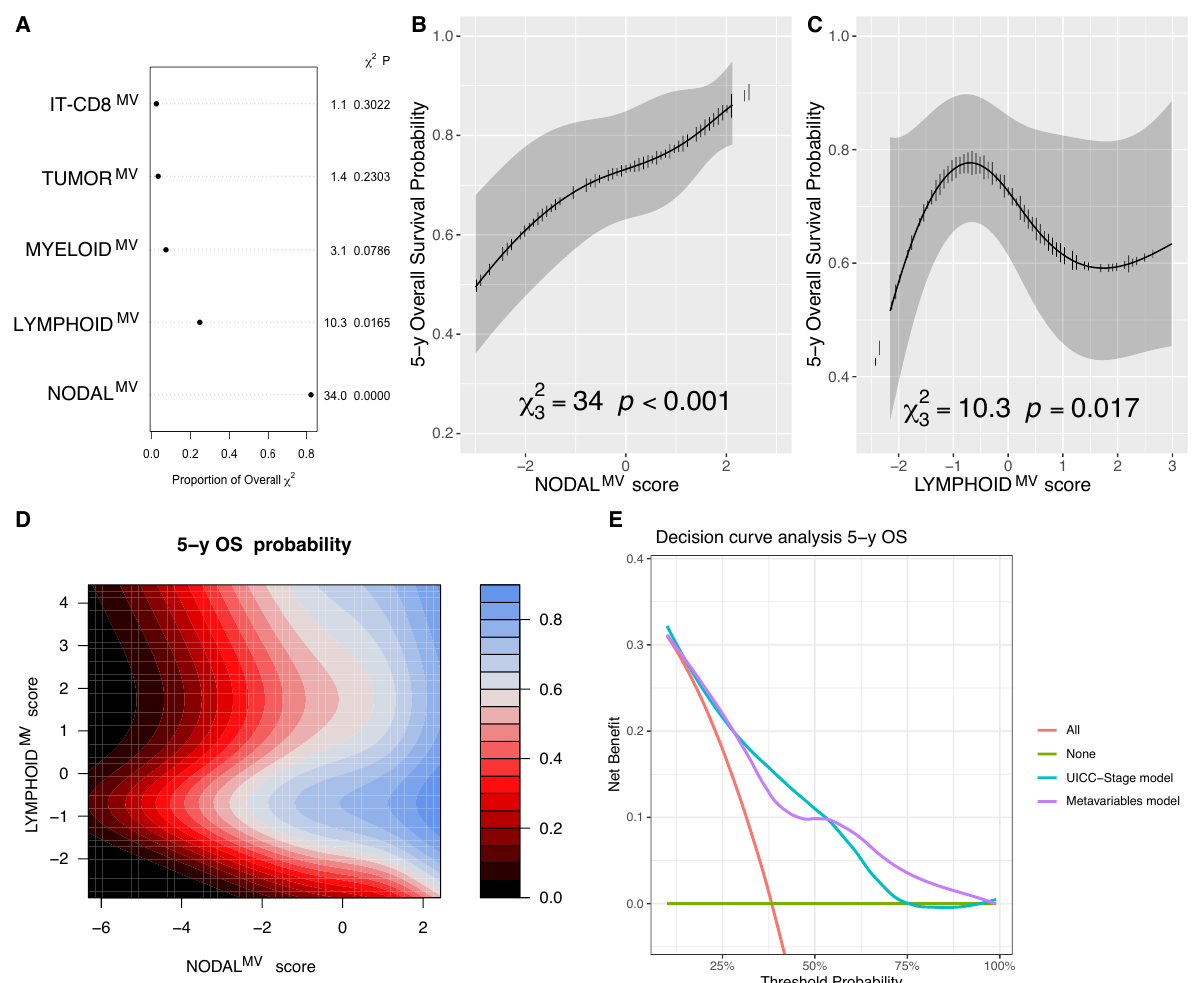
Figure 3. Chunk test results on the OS multivariable model reporting the proportion of the overall χ 2 of the model explained by each variable, the partial χ 2 and P value of the Wald test, testing the association between each variable and the outcome ( A ); adjusted marginal effect plot of the NODAL MV score for the 5-year OS estimate with the CI 95% gray band ( B ); adjusted marginal effect plot of the LYMPHOID MV score for the 5-year OS estimate with CI 95% gray band ( C ); contour plot showing isoprognostic OS bands according to the combined effect of the NODAL MV and LYMPHOID MV scores for the 5-year OS estimate, the color scale represents the 5 y OS probability ( D ); and decision curve analysis (DCA) analysis showing comparable results of the model including metavariables and to the one fitted with UICC overall stage alone in predicting the 5-year OS ( E